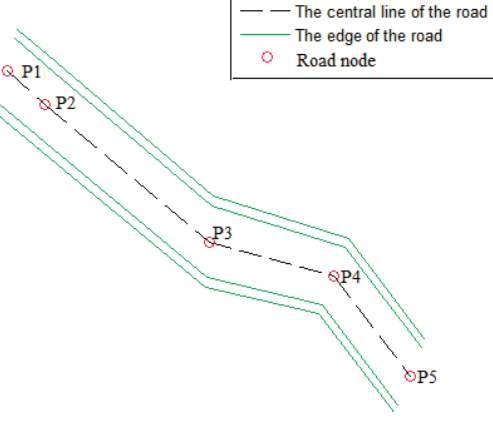
Figure 15. Example of a road with direction and height changes.